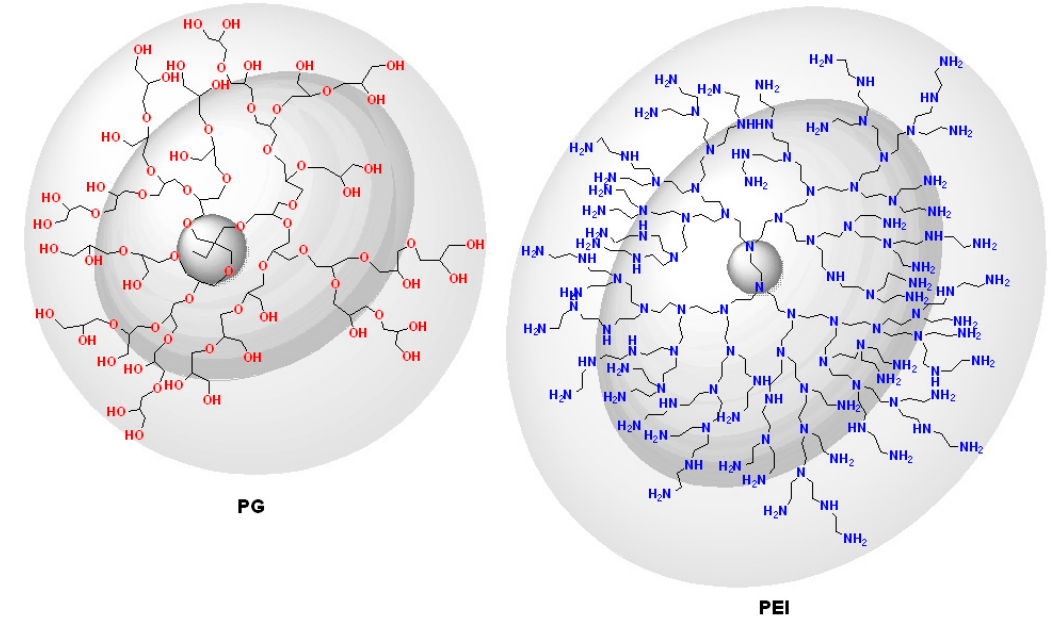
Figure 3. Chemical structures of hyperbranched polyglycerol (PG), and hyperbranched poly(ethylene imine) (PEI).